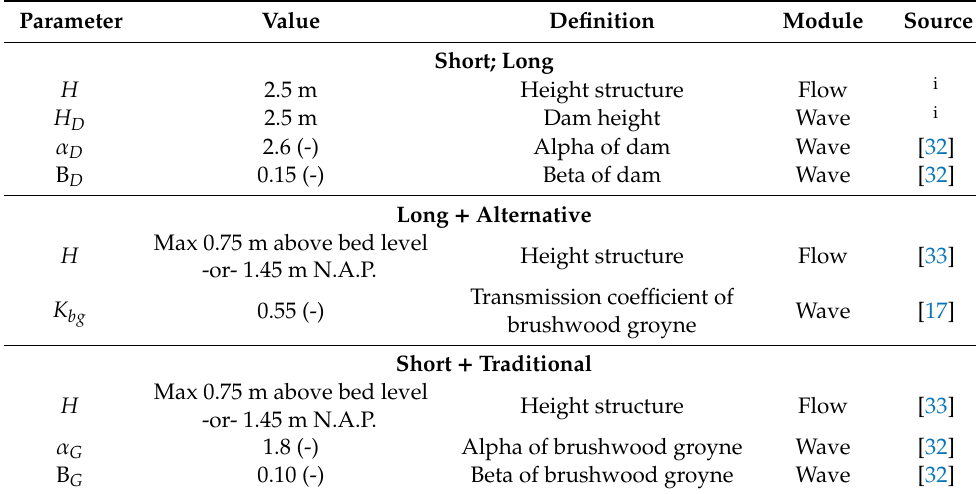
Table A2. Input parameters applied for the implementation of artificial